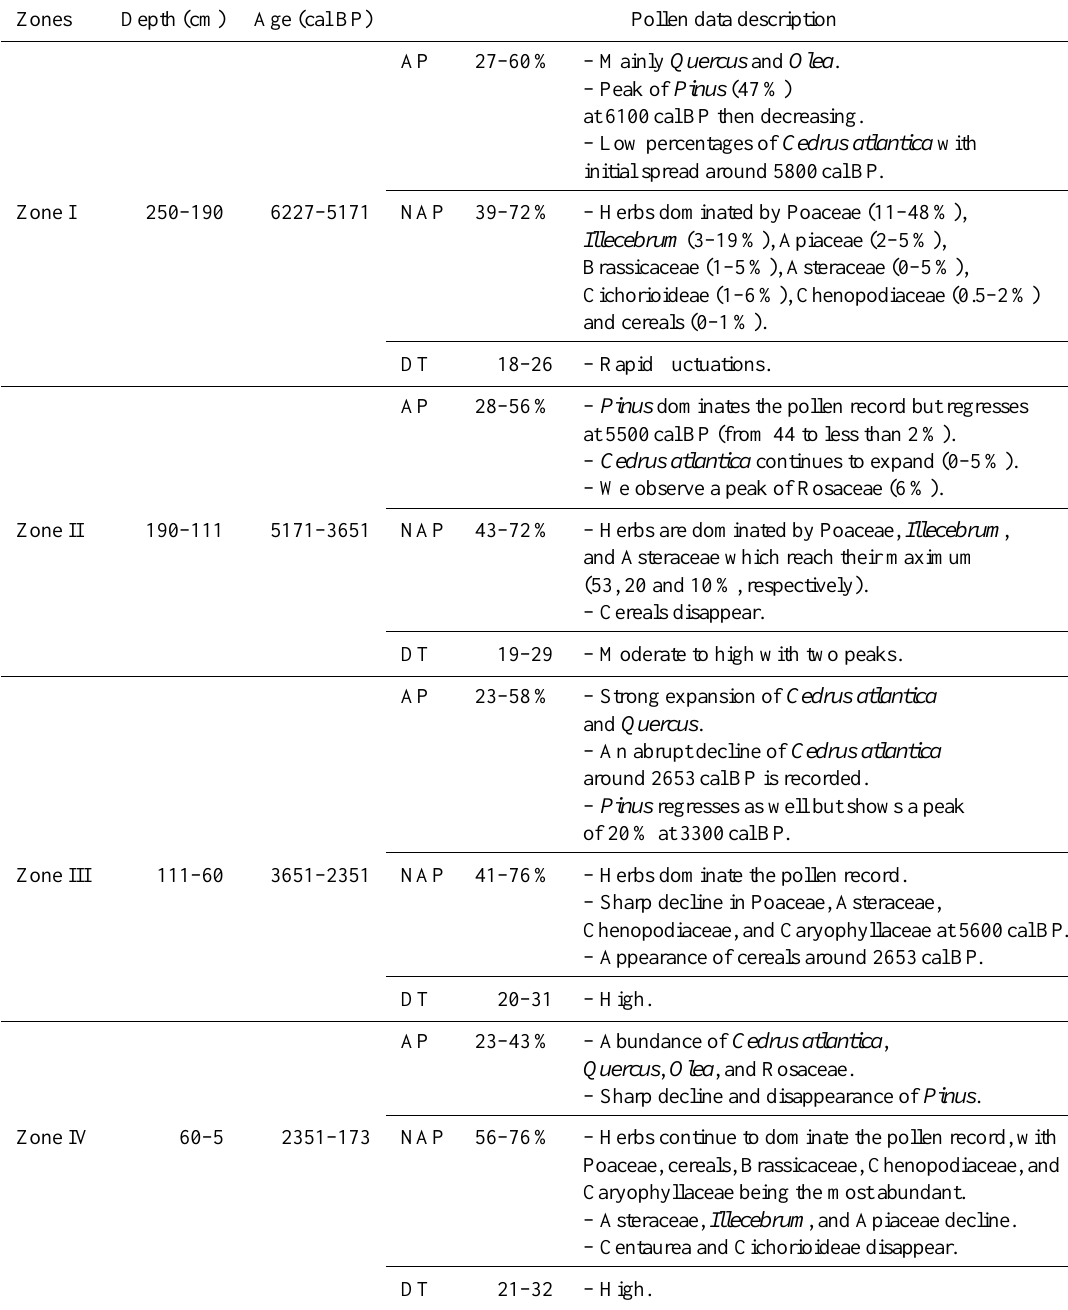
Table 3. Pollen zones identified in the fossil record using a constrained cluster analysis. AP: arboreal pollen taxa; NAP: non-arboreal pollen taxa; DT: taxa